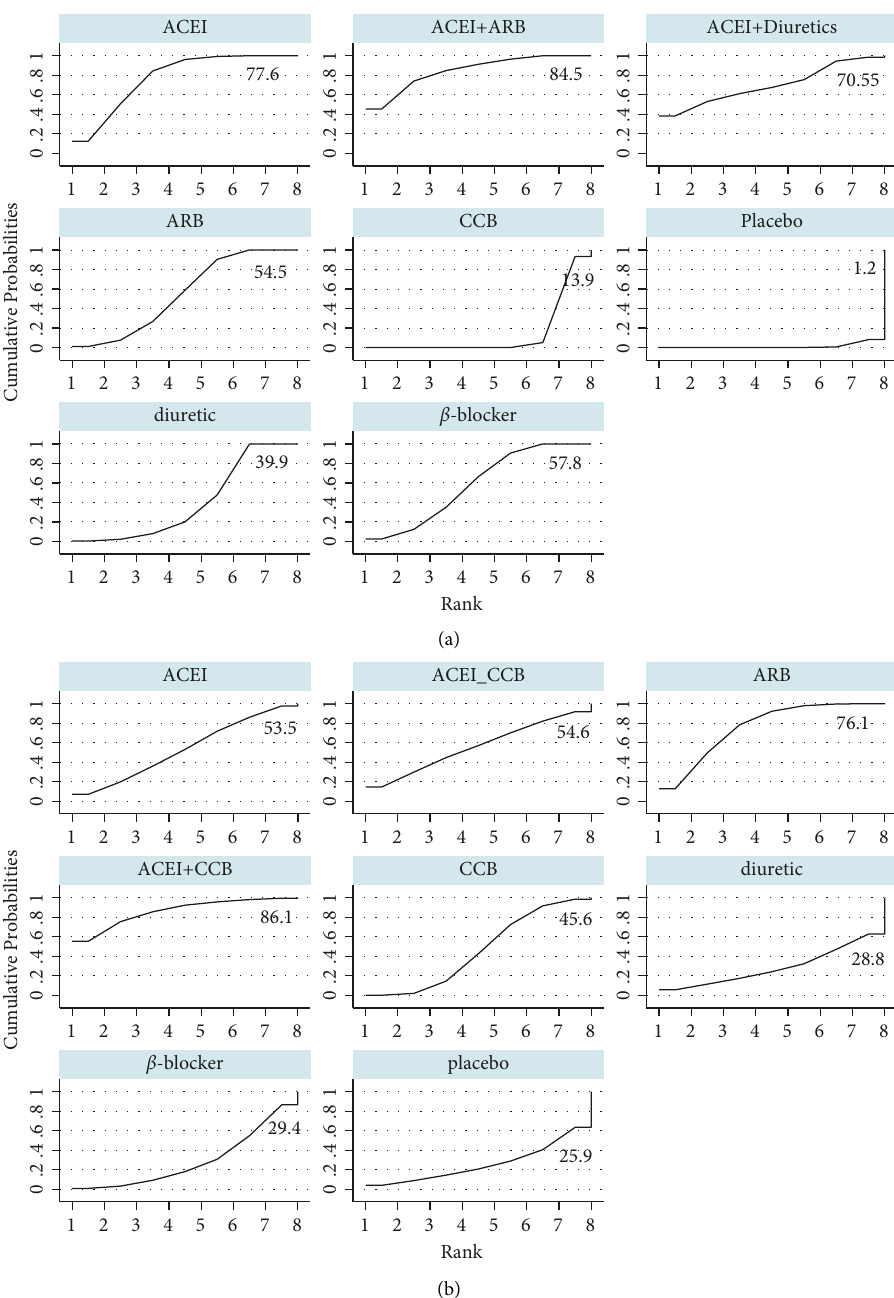
Figure 12: Subgroup analysis of cumulative ranking probability plot for the assessment of duration treatments in FMD. (a) Age ≤ 55 years, (b) aged ＞ 55 years). ACEI: angiotensin-converting enzyme inhibitors, ARB: angiotensin receptor blocker, CCB: calcium channel